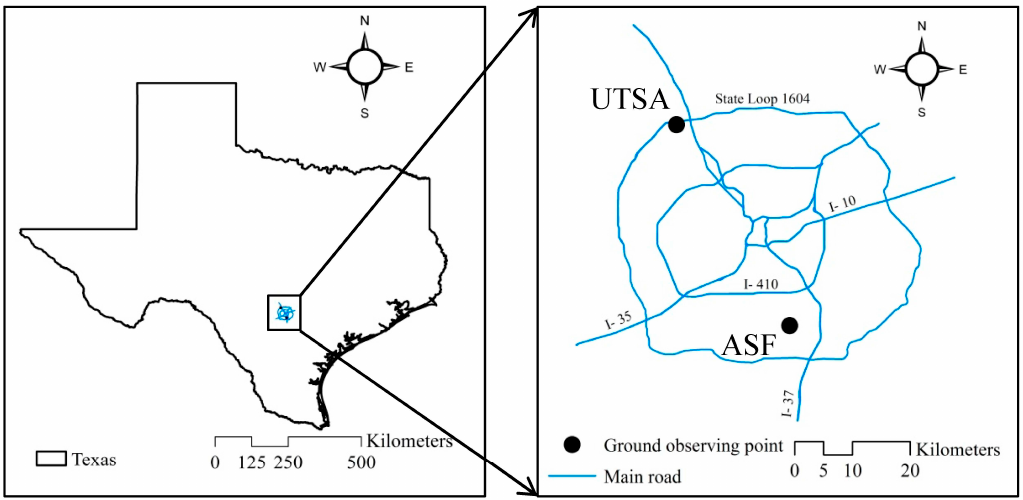
Figure 1. Map of the state of Texas showing the locations of the City of San Antonio ( left panel ) and of the in situ measurement sites, UTSA and ASF, relative to main roads in the San Antonio Area ( right panel ).